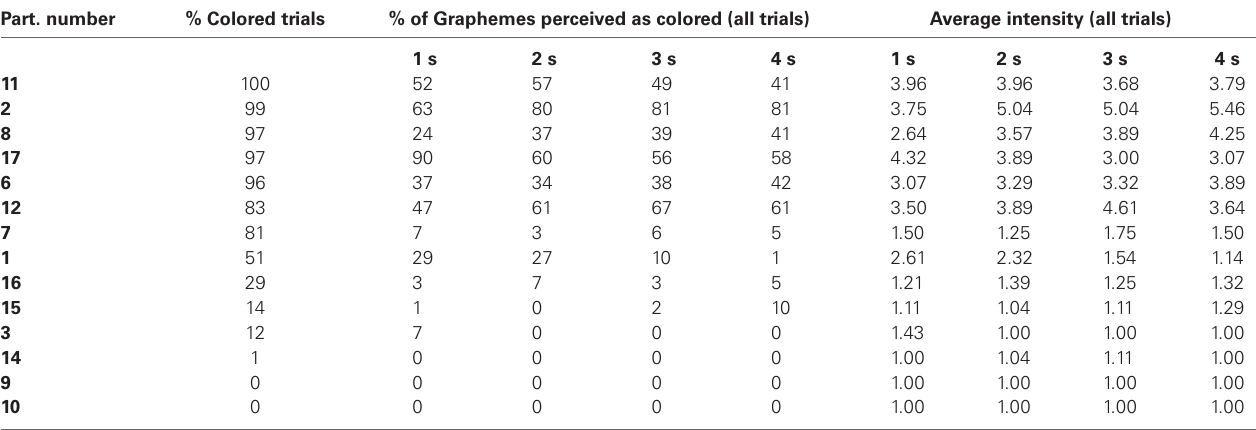
Table 1 | Summary of subjective color experiences for each participant for the hypnosis condition only in descending order from the participant who experienced color for the most trials to least . Part. number % Colored trials % of Graphemes perceived as colored (all